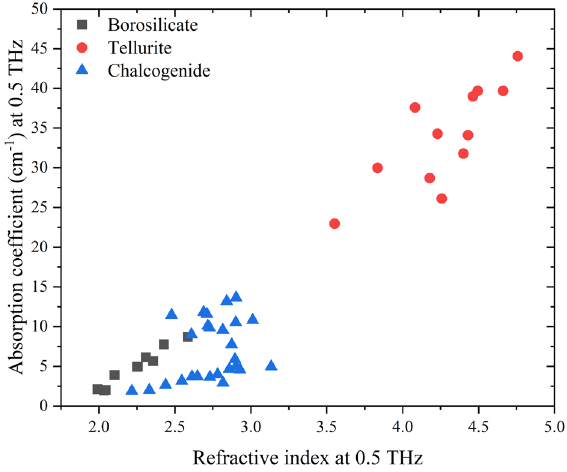
Figure 4. 0.5 THz absorption coefficient and refractive index correlation.